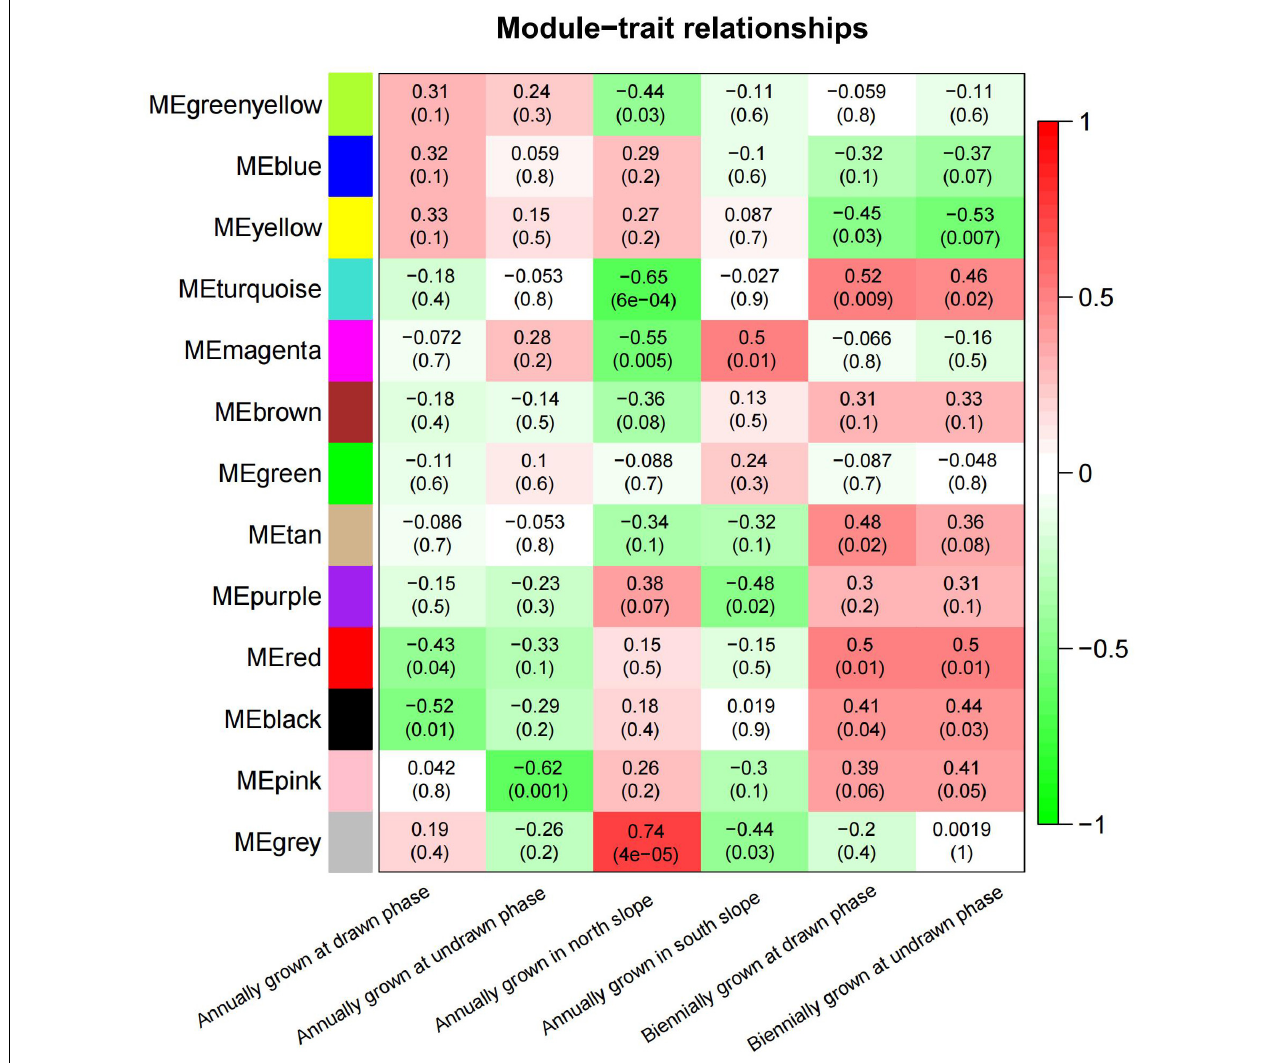
FIGURE 9 | The module–trait relationship between six conditions and